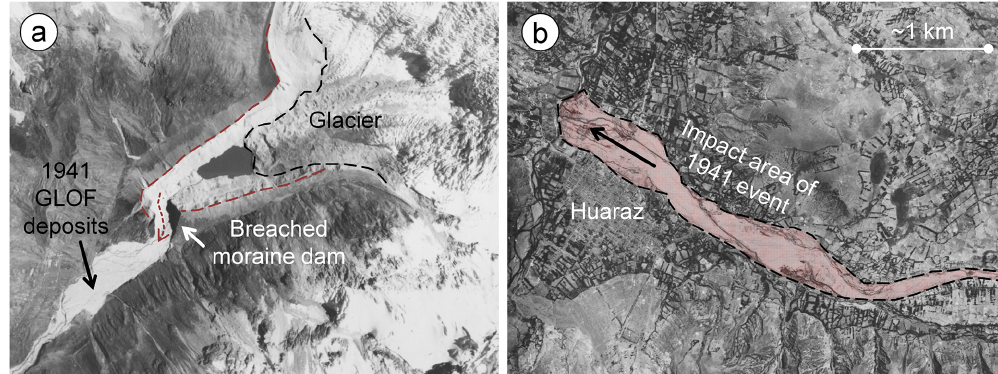
Figure 3. Situation in 1948, seven years after the 1941 event. (a) Residual Lake Palcacocha, and traces of the 1941 event. (b) Huaráz with the impact area of the 1941 event. Imagery source: Servicio Aerofotogramétrico Nacional,